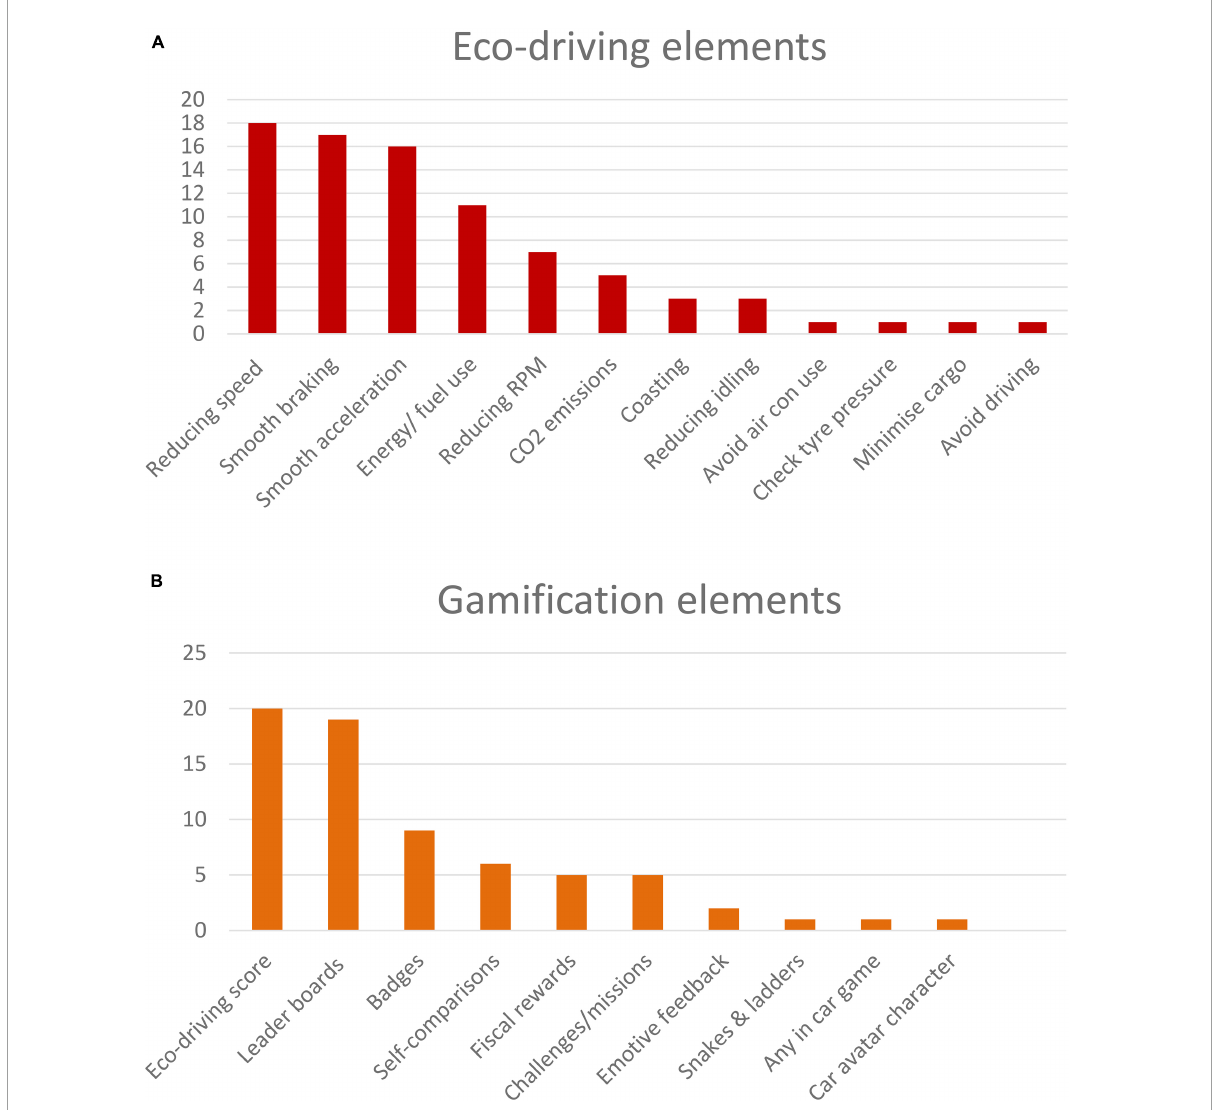
FIGURE2 Eco-driving elements (A) and gamification elements (B) deployed across the 34 adjunct studies.